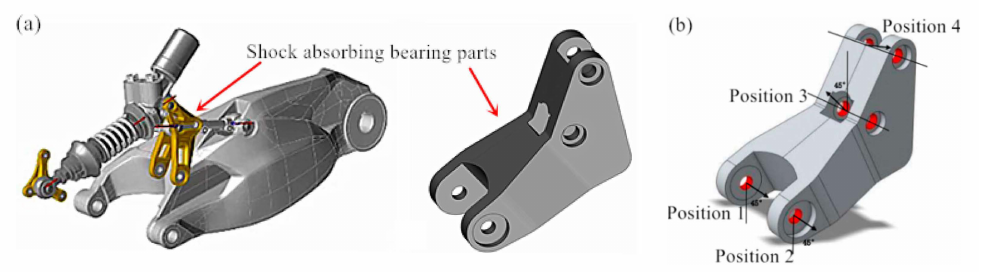
Figure 1. Motorcycle shock-absorbing bearing parts: ( a ) Filling effect and ( b ) Restraint and load application